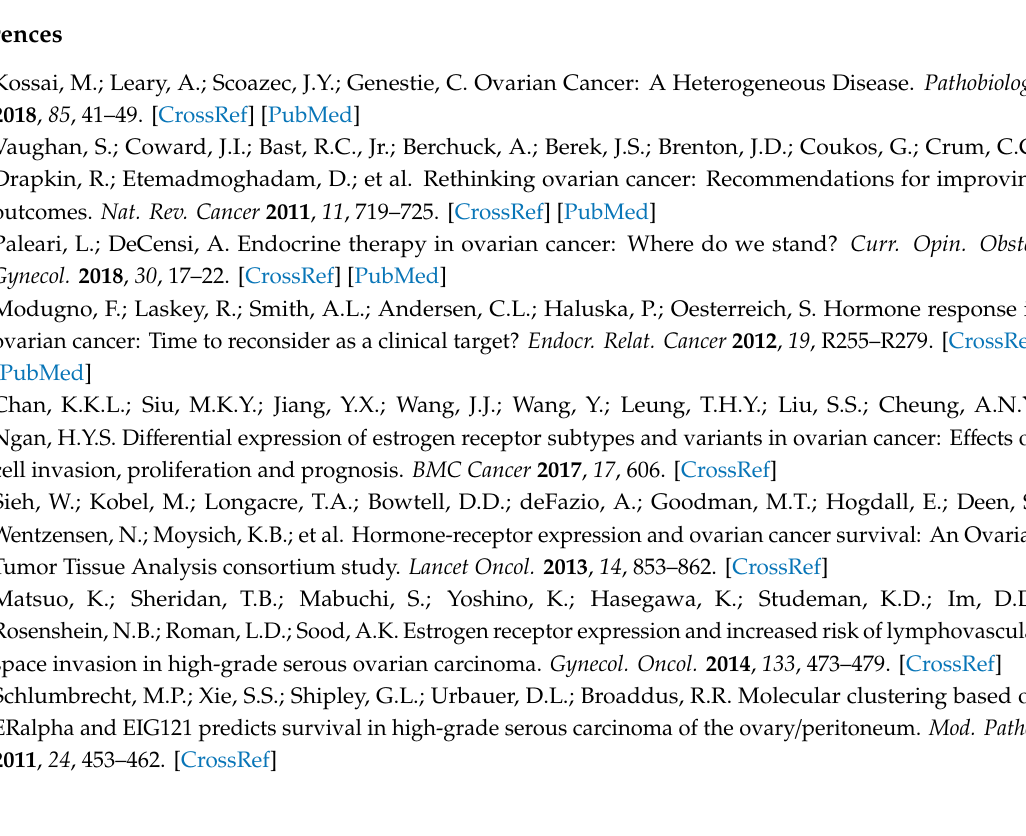
Figure S1: H3K79 methylation and cell proliferation inhibition by selective DOT1L blockage with EPZ-5676 or SGC0946, Figure S2: E ff ects of EPZ on ER α -negative OC cell transcriptome, Figure S3: ER α expression analysis following alternative DOT1L inhibitors treatment, Figure S4: e ff ect of EPZ00477 histone transcription markers, Figure S5: ER α and DOT1L binding to EPZ-downregulated genes, Figure S6: DOT1L gene expression correlates with clinical behavior of OC and is an essential gene in a large number of OC cell models, Table S1: PEO cells undergoing di ff erential expression analysis, Table S2: Transcripts di ff erentially regulated in both PEO1 and PEO4 cells by EPZ and ICI showing one or more ERE motifs in the